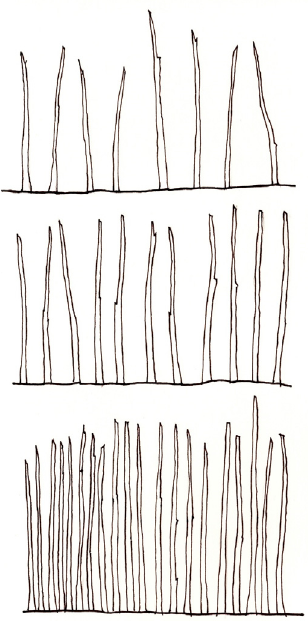
Figure 4. Graphic study on permeability on fences found in the Cordoba landscape. Source: Massimo Leserri, 2017 [4].